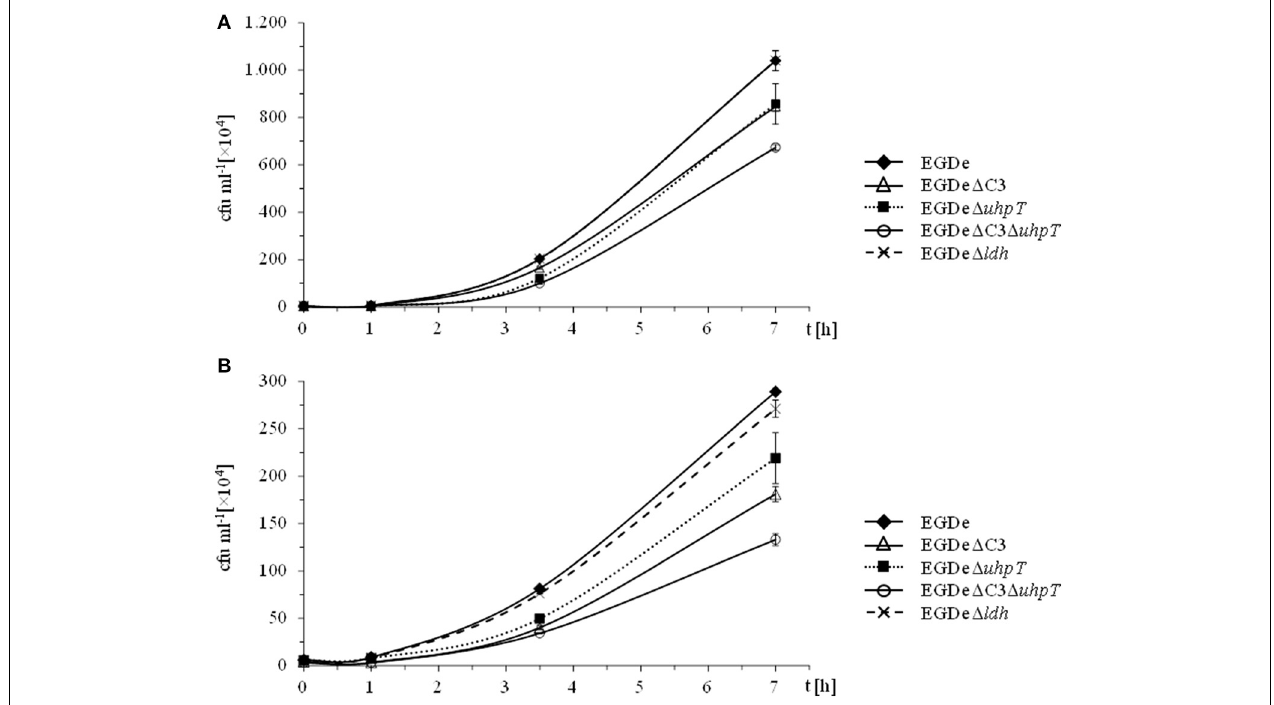
FIGURE 1 | Intracellular replication behavior of L. monocytogenes . L. monocytogenes EGDe and its mutants were used to infect J774A.1 macrophages in the presence of 10mM glucose (A) or 20mM glycerol (B) . 45min after infection, extracellular bacteria were